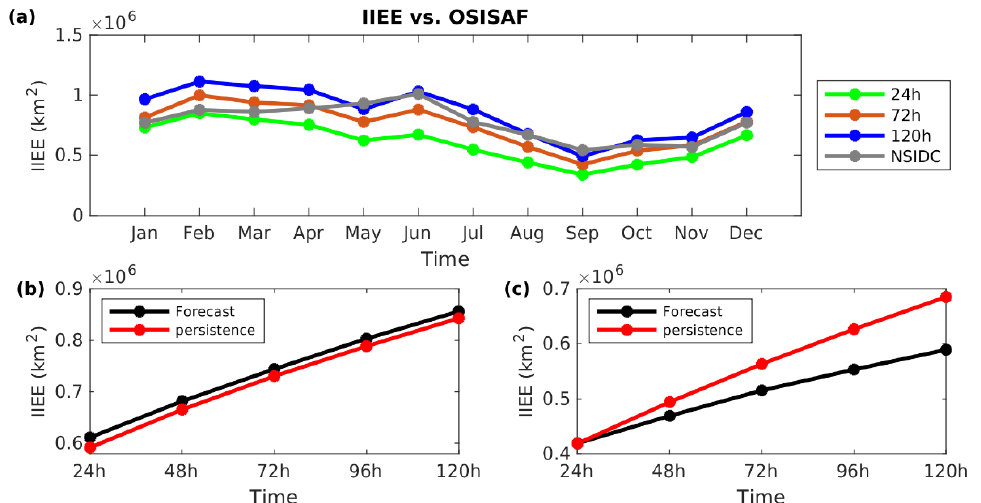
Figure 9. The IIEE between FIO-COM10 forecast and OSISAF observation. ( a ) Monthly-mean IIEE time series from January to December 2021 in the Arctic region. ( b ) Annual-mean IIEE of forecast and the corresponding persistence forecast for different lead time in 2021. ( c ) Mean IIEE during 1 August to 30 November 2021 of forecast and the corresponding persistence forecast for different lead time.